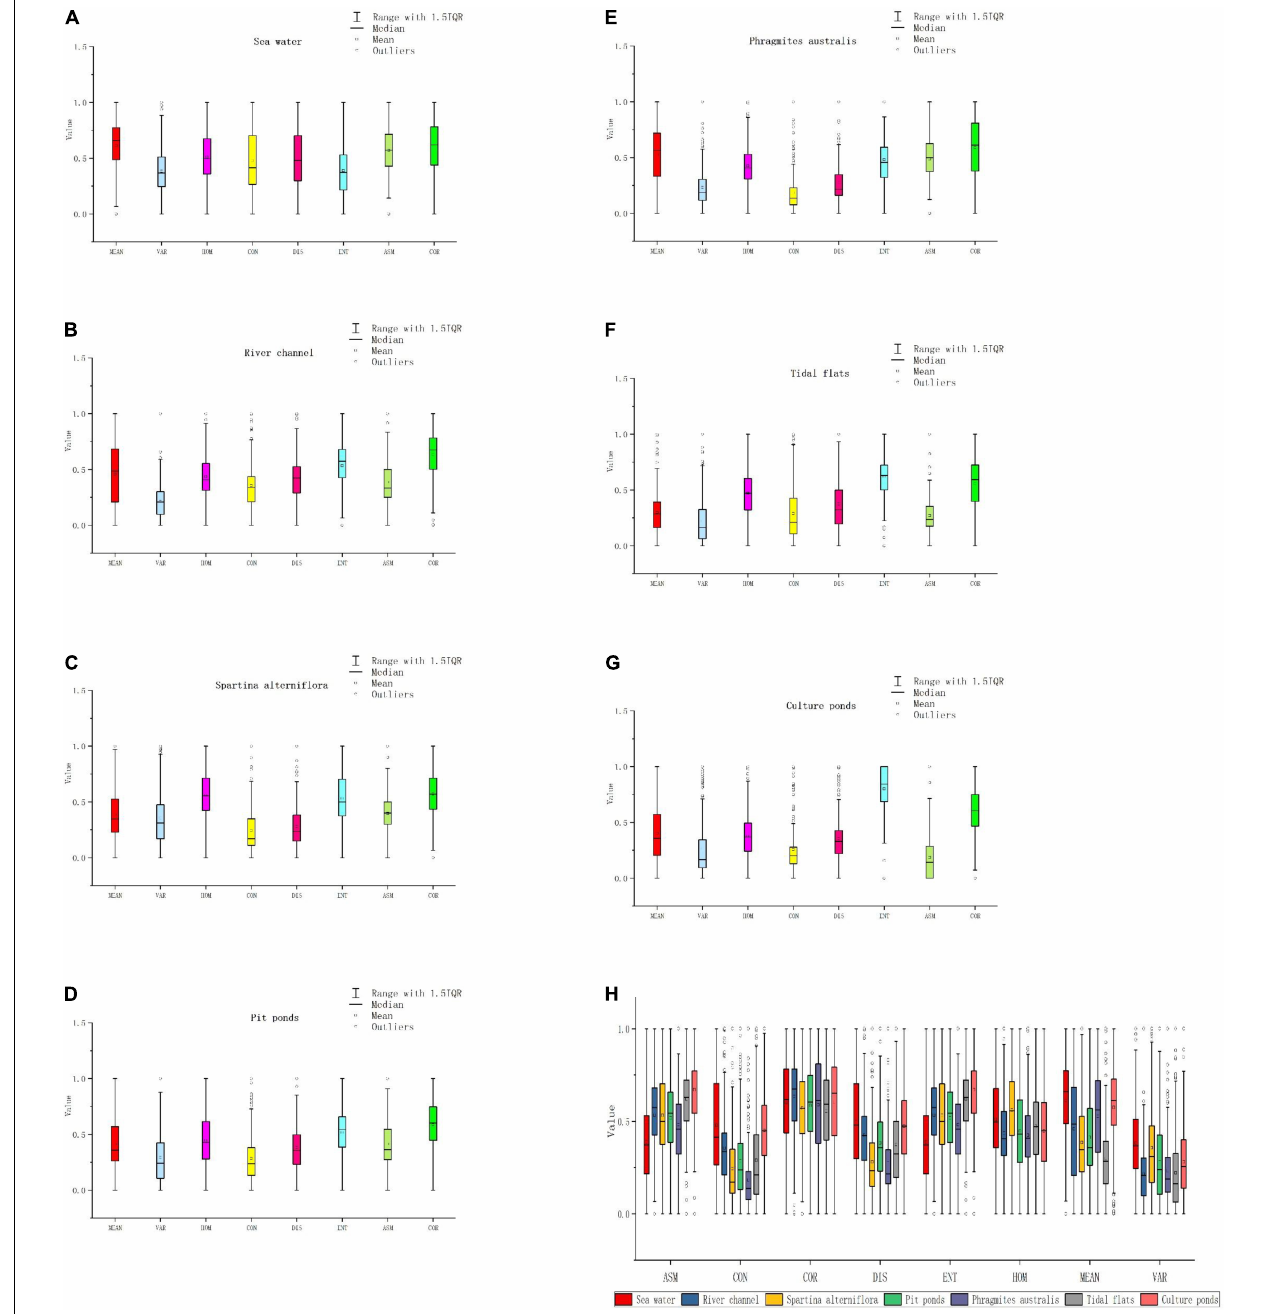
FIGURE 10 | Box-plots of polarimetric texture features. (A–G) Represent the eight texture feature box plots of sea water, river channel, S. alterniflora , pit ponds, P. australis , tidal flats and culture ponds, respectively. (H) Is the box-plot of eight texture features of different objects.